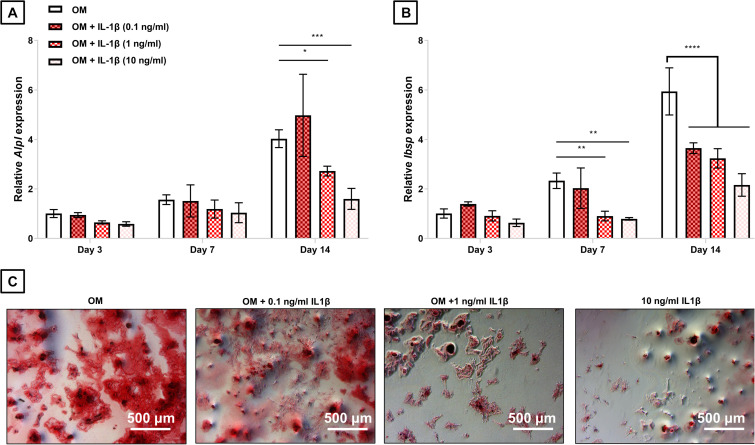
Effect of sustained IL-1β treatment on expression of osteogenic markers in rat BM-MSCs. Cells were cultured with osteogenic medium (OM) or OM treated with IL-1β (0.1, 1, and 10 ng/ml). The expression of (A)
Alpl and (B)
Ibsp were determined in response to these treatments after 3, 7, and 14 days in culture. (C) Mineral deposition in response to these treatments was assessed after 21 days. *, **, ***, and **** denotes p < 0.05, 0.01, 0.001, and 0.0001 respectively. Data is normalized to gene expression of cells cultured in OM at day 3. Relative quantification was determined using the 2– ΔΔCT method. Data plotted represents mean ± standard deviation, n = 3.